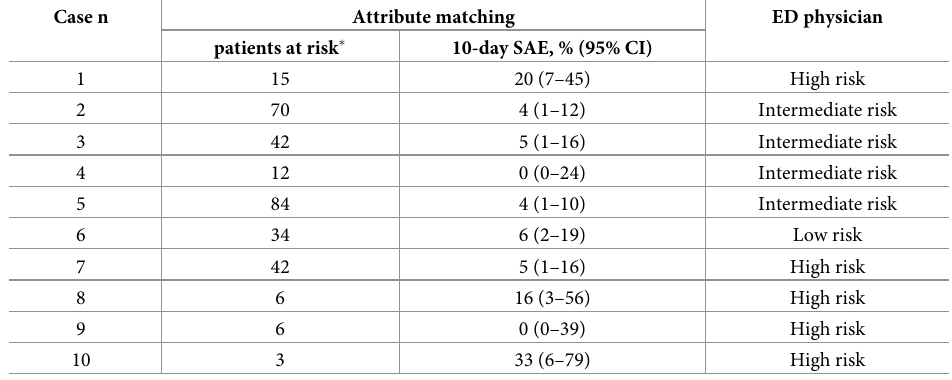
Table 4. Predicted probabilities according to attribute matching and clinical judgement in the 10 example